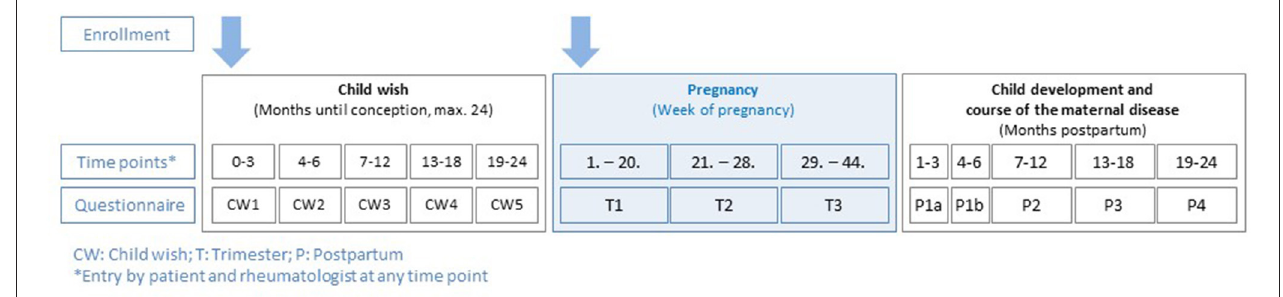
FIGURE 1 | Rhekiss assessment schedule from the three modules (child wish, pregnancy, and post-partum).